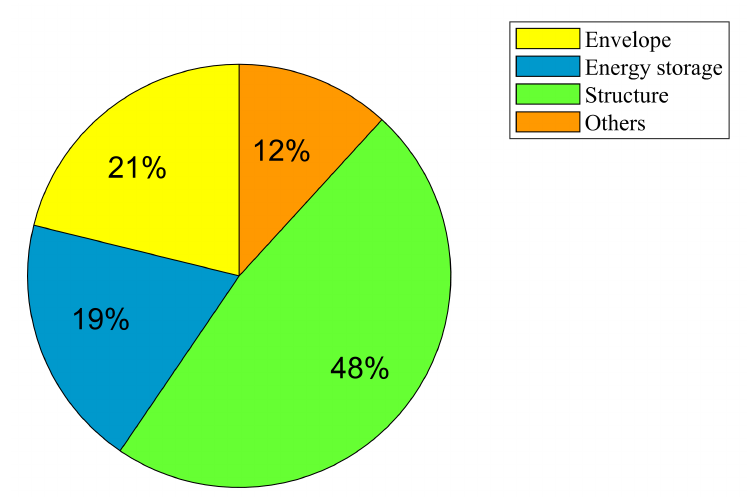
Figure 22. Conventional airship, I day = 172.